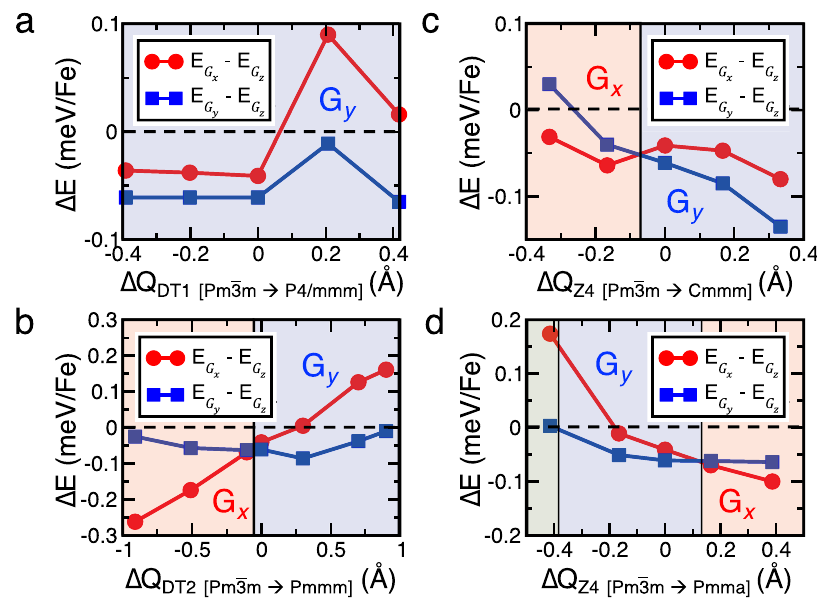
Fig. 6 Effects of structural modulations on the stability of magnetic phases of PbFeO 3 . Calculated relative energies of G x , G y , and G z magnetic phases as functions of the modulation of the structural distortions corresponding to the DT 1 (transforms Pm 3 m ! P 4 = mmm , a ), DT 2 (transforms Pm 3 m ! Pmmm , b ), Z 4 (transforms Pm 3 m ! Cmmm , c ) and Z 4 (transforms Pm 3 m ! Pmma , d ) symmetries with respect to the crystal structure experimentally determined at 300 K (S Expt